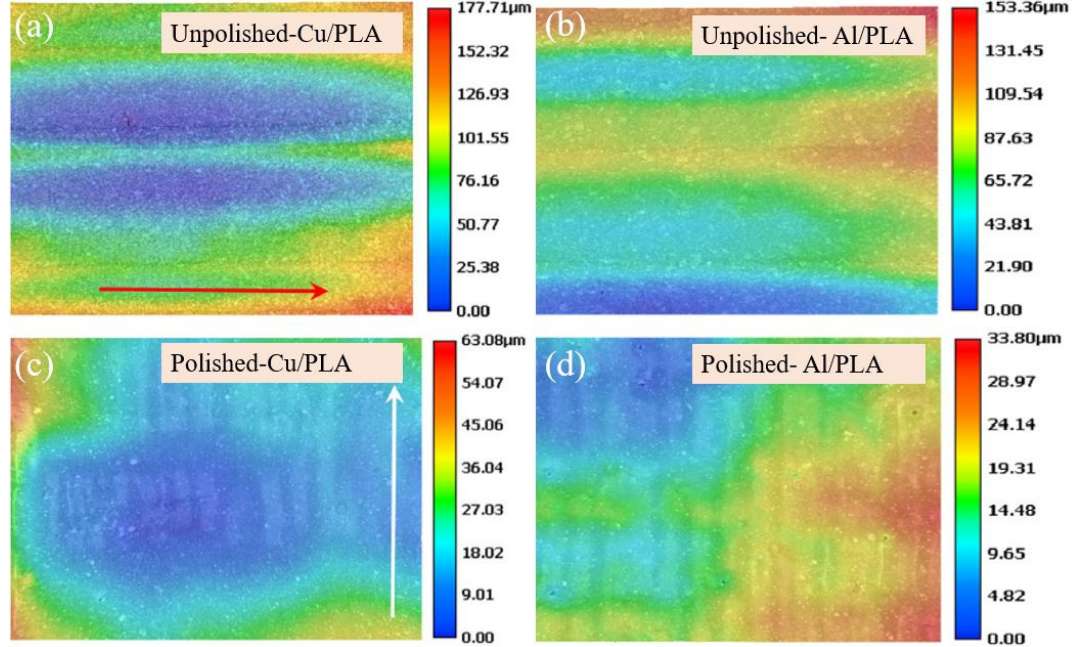
Figure 19. Surface topographies of: ( a ) unpolished Cu/PLA specimen; ( b ) laser polished Cu/PLA specimen with reduced surface roughness; ( c ) unpolished Al/PLA specimen; ( d ) laser polished Al/PLA specimen with reduced surface roughness. ( a ), ( c ): [237], ( b ), ( d ): [238].